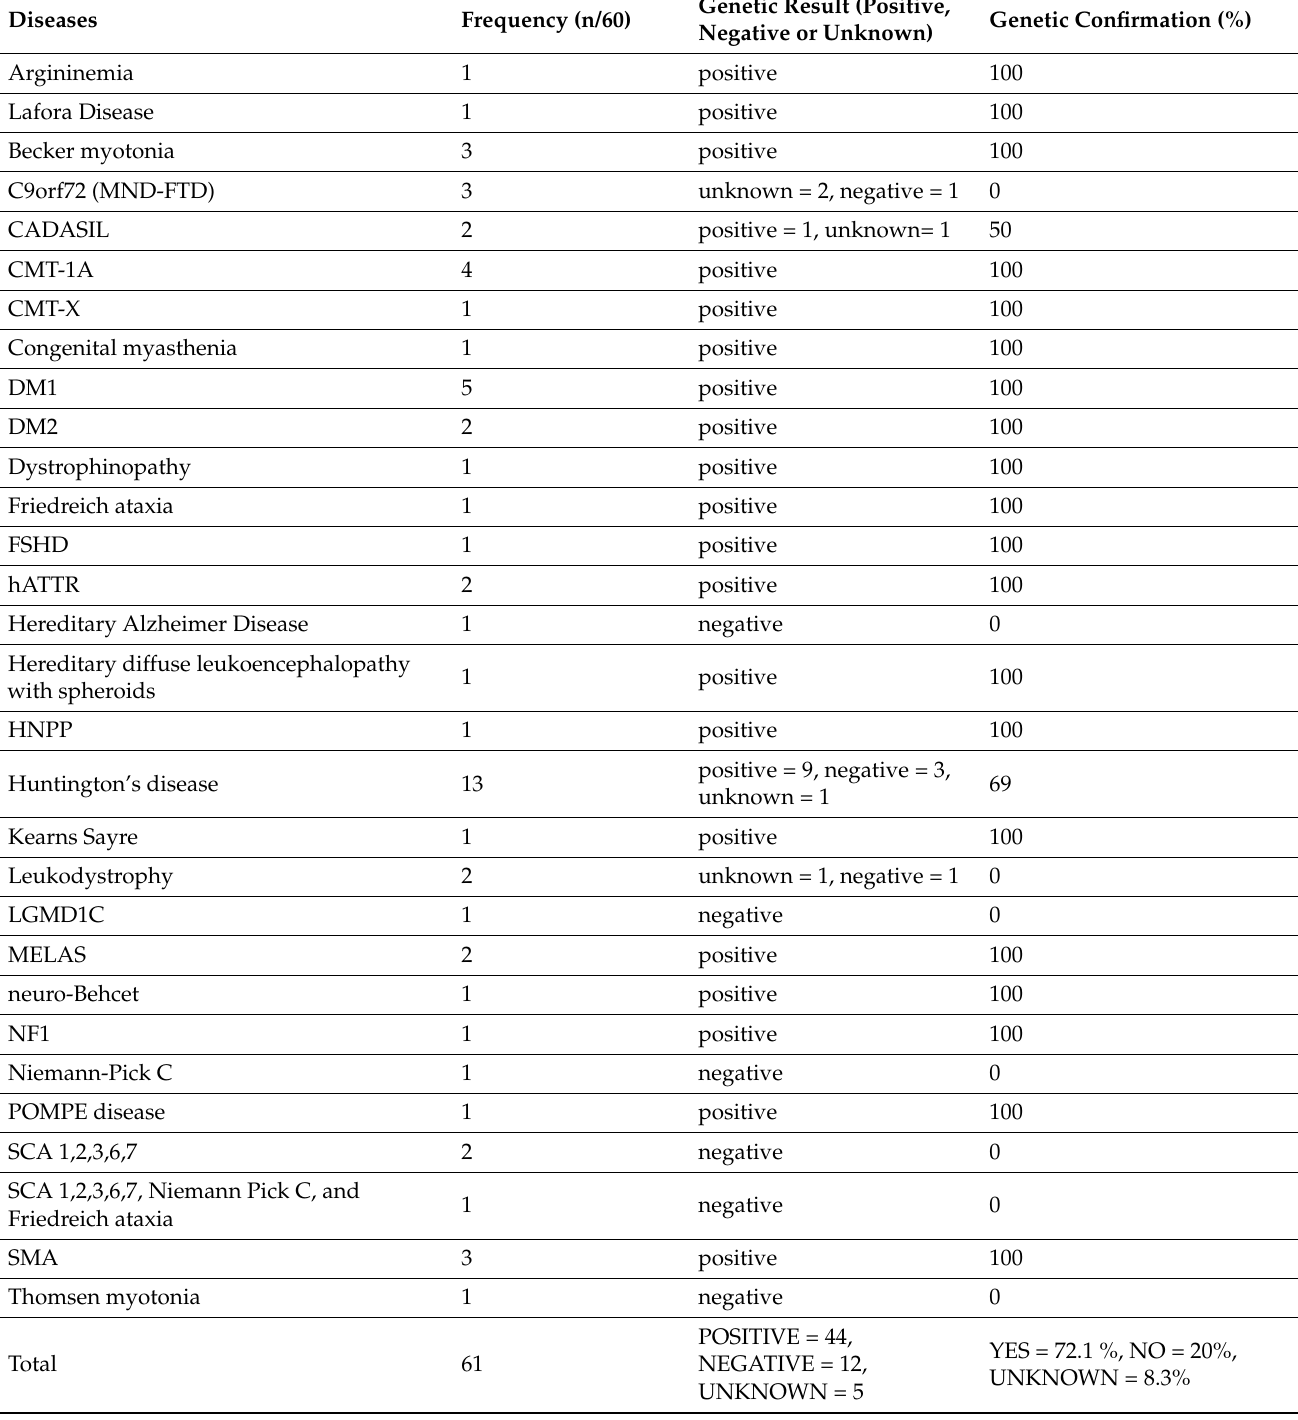
Table 2. Number of Rare Neurological Diseases in which a genetic test was undertaken; the genetic results and the confirmation rates are also